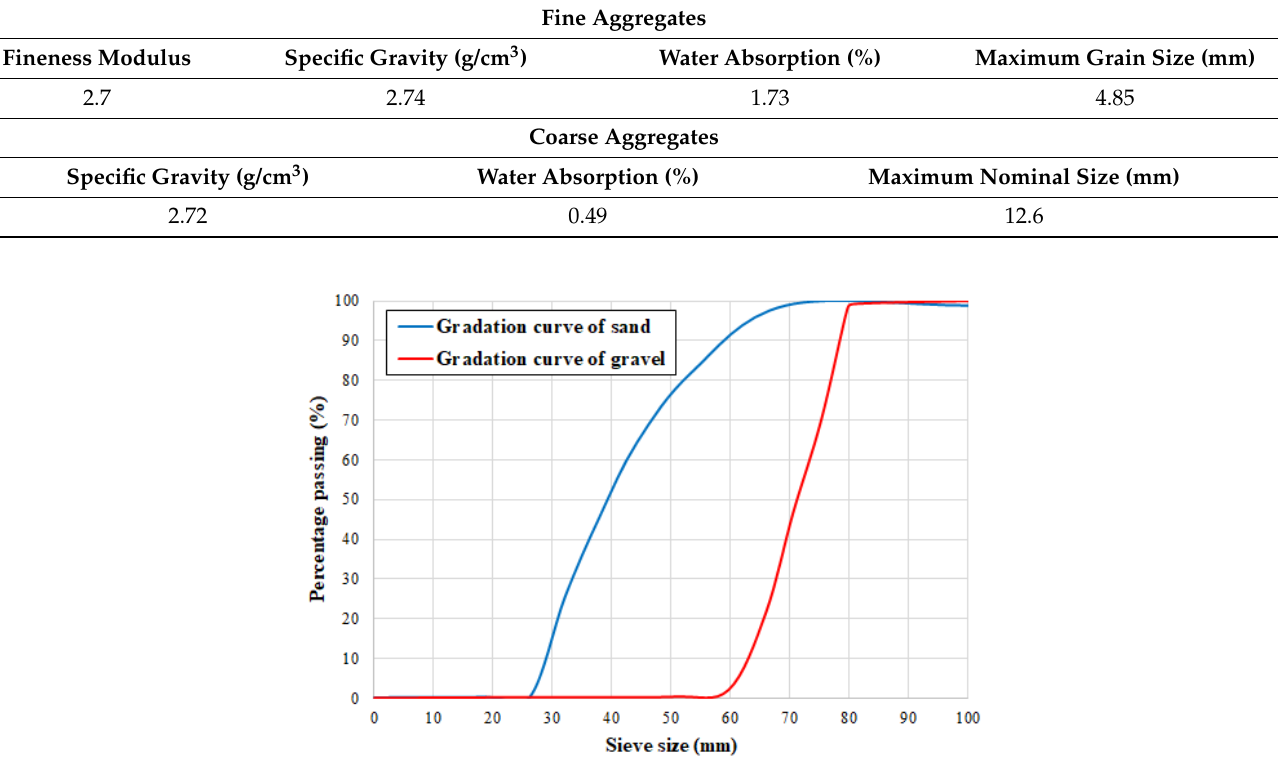
Figure 1. Gradation curve of aggregates. Table 4. Grading of the